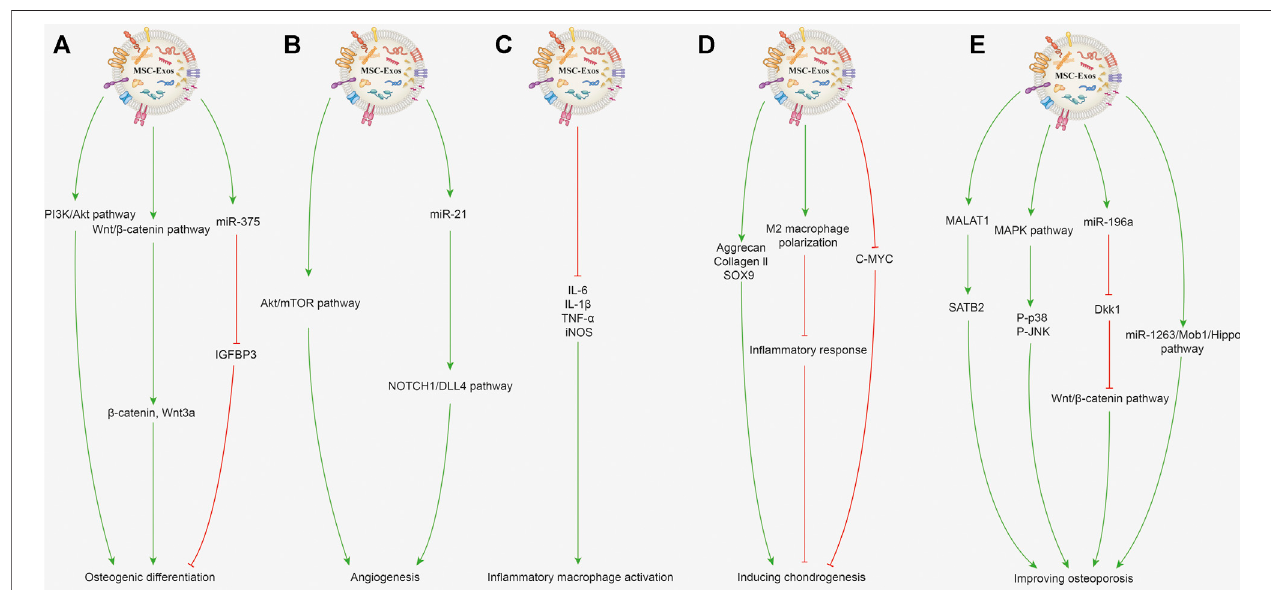
FIGURE3| PotentialmechanismsofMSC-Exos forpromotingbone repair and regeneration. (A) Promoting osteogenic differentiation.MSC-Exos canactivate the PI3K/Akt signaling pathway to promote osteogenic differentiation and proliferation of BMSCs. The Wnt/ β -catenin signaling pathway activated by MSC-Exos with increasedexpressionof β -cateninandWnt3acanpromoteosteoblastproliferationanddifferentiation.ExosomesenrichedwithmiR-375inhibittheIGFBP3expressionto promote osteogenic differentiation of hBMSCs. (B) Promoting angiogenesis. BMSC-Exos activates the Akt/mTOR pathway to stimulate angiogenesis and further promotes bone regeneration. Exosomal miR-21 can upregulate the NOTCH1/DLL4 pathway and promote angiogenesis. (C) Immunoregulation. MSC-Exos can decrease the gene expression of IL-1 β , IL-6, TNF- α , and iNOS in the in fl ammatory macrophages. (D) Inducing chondrogenesis. MSC-Exos increase the protein and mRNA expression of collagen II and SOX9 to improve cartilage regeneration. MSC-Exos can promote the macrophage ’ s polarization toward the M2 phenotype and furtherinhibitthein fl ammatoryresponsetobene fi tchondrogenesis.BMSC-Exotreatmentcandecrease thec-MYCexpression level,whichindicates thechondrocyte ’ s maturation. (E) Improving osteoporosis. MALAT1 contained in BMC-Exos promotes alkaline phosphatase activity of osteoblasts and mineralizes nodules by increasing SATB2 expression. Activating MAPK signaling and increasing the P-p38 and P-JNK expression by MSC-Exos can promote osteoblast differentiation. BMSC-Exos enriched with miR-196a can inhibit Dkk1 expression to activate the Wnt/ β -catenin pathway, thereby improving osteoporosis. Exosomes derived from human umbilical cord MSCs can inhibit BMSC apoptosis through the miR-1263/Mob1/Hippo signaling pathway to improve osteoporosis.